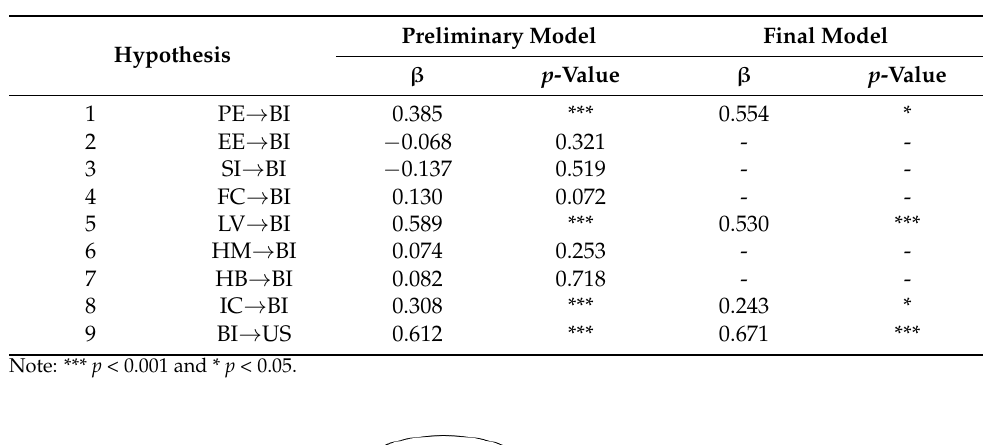
Table 3. Final model fit.